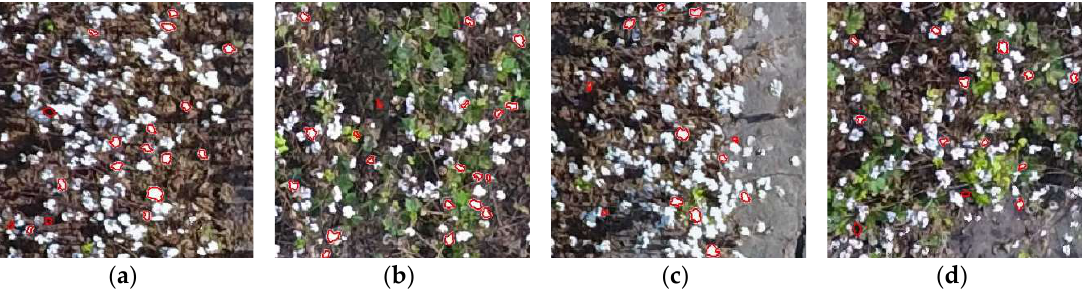
Figure 10. Enlarged cotton boll candidates. ( a ) N1; ( b ) S1; ( c ) N2; ( d ) S2.